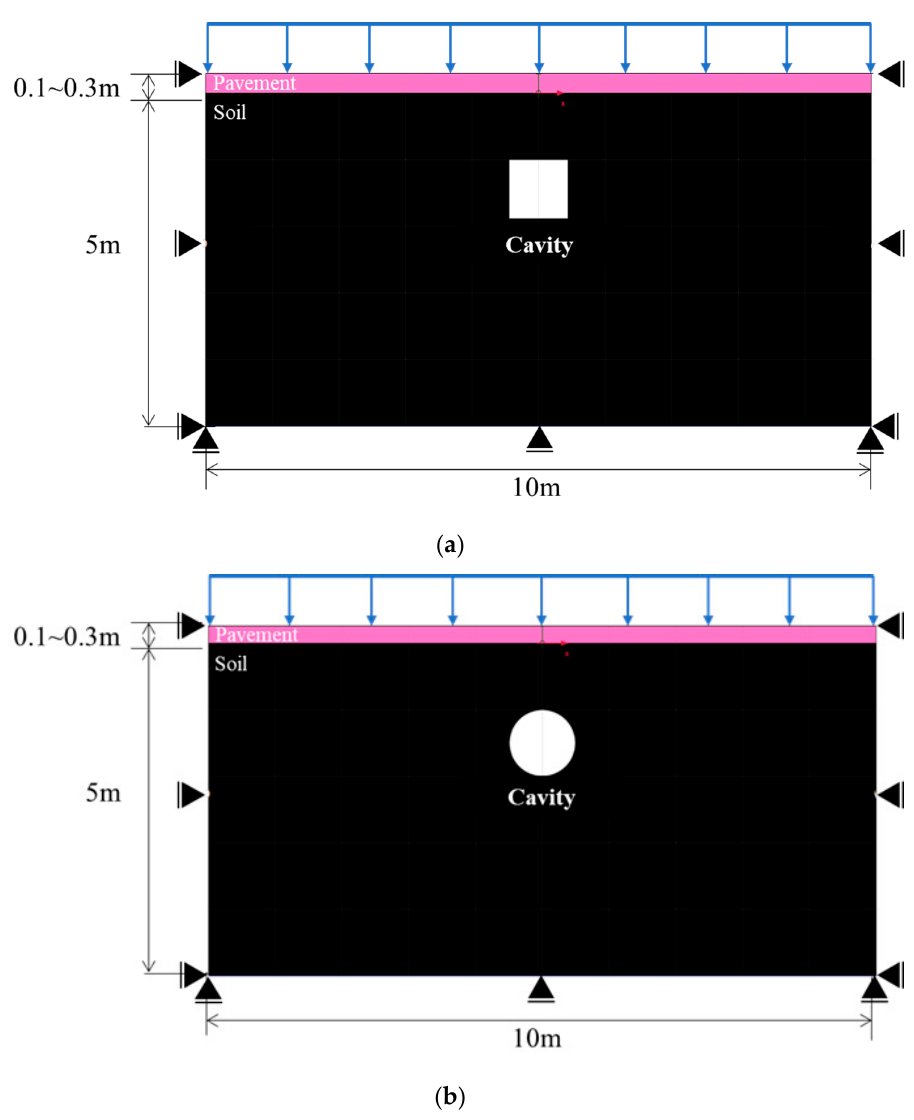
Figure 5. Numerical analysis model for the evaluation of influencing factors. ( a ) Rectangular and ( b ) circular cavities.